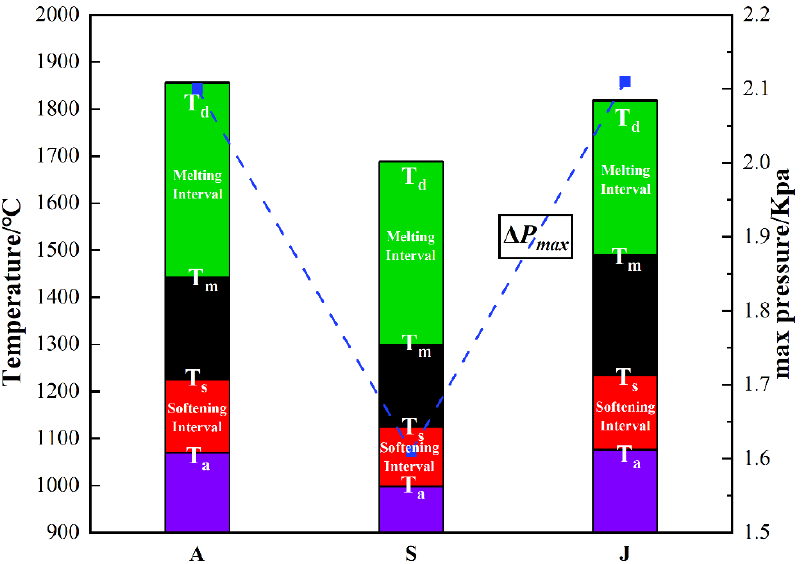
Figure 8. The high temperature softening and melting properties of three lump ores. (T a , starting softening temperature; T s , softening termination temperature ; T m , starting melting temperature; Td, starting dropping temperature; max , permeability).